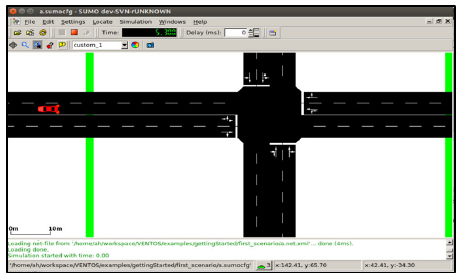
Fig. 1. Scenario 1: A Trusted Vehicle Communicates with the RSU to Inform about Accident